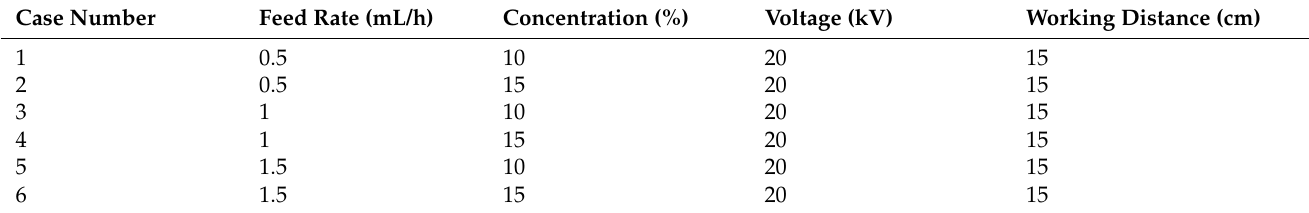
Table 1. Description of electrospun